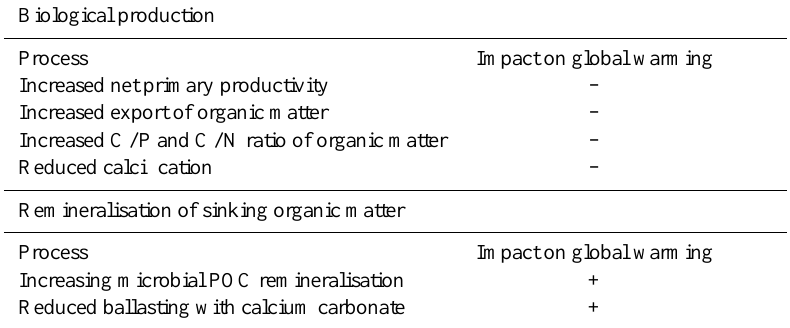
Table 1. Potential ocean acidification impacts on BGC cycles. A positive value in the Impact on global warming column signifies the process causes greater warming (positive